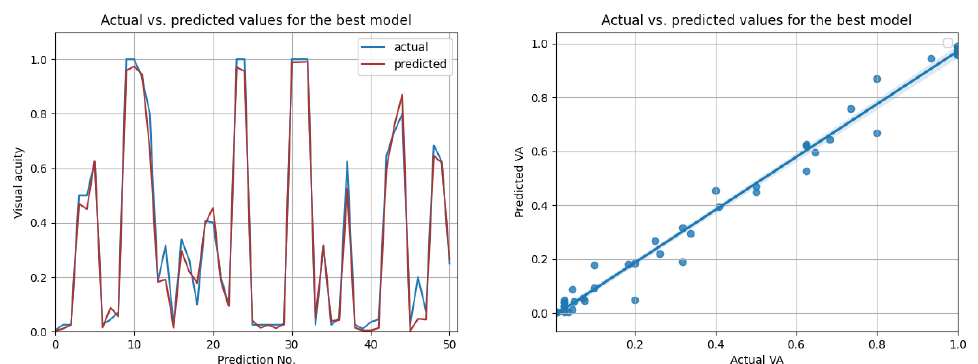
Figure 13. Actual vs. predicted VA values for the best model (LSTM with R 2 = 0.98, for three previous visits). The second figure shows that the actual and predicted visual acuities are highly correlated ( r = 0.993).